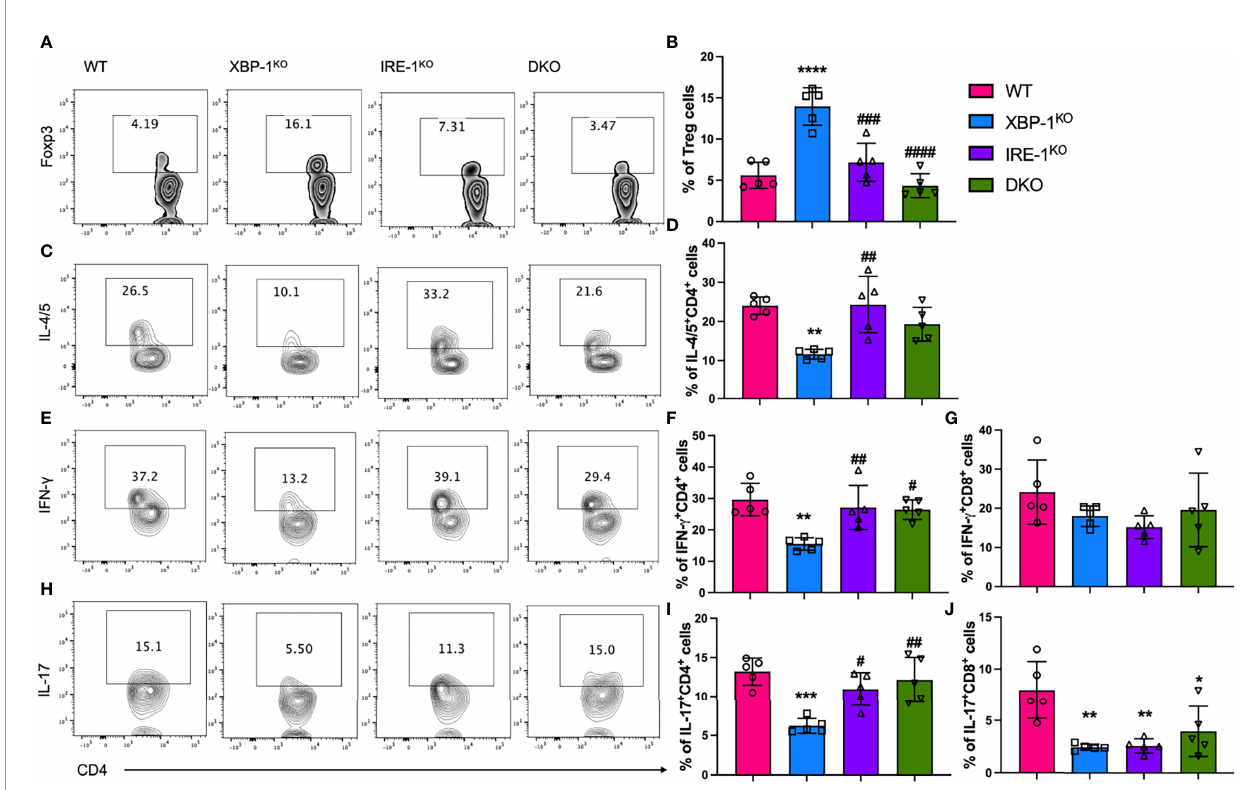
FIGURE 5 | Effect of XBP-1s and IRE-1 a on B cell ability to stimulate allogeneic T cells during cGVHD. Lethally irradiated BALB/c mice were transplanted with 5 x 10 6 TCD-BM cells from WT, XBP-1 KO , IRE-1 a KO , and DKO mice on a B6 background with 0.35 - 0.5 x 10 6 splenocytes (n=20). Recipient mice were euthanized on day 28 after BMT and single cells were isolated from recipient spleens. The expression of Foxp3 transcription factor (A, B) was measured by fl ow cytometry analysis. The cytokine levels in CD4 and CD8 T cells including IL-4/IL-5 (C, D) , IFN- g (E – G) , and IL-17 (H – J) were determined after intracellular staining by fl ow cytometry analysis. Data show the representative result from three independently repeated experiments. 20 recipient mice were used for each experiment. Statistics were performed using two-way ANOVA with Tukey ’ s multiple comparison test. *p < 0.05, **p < 0.005, ***p < 0.0005, and ****p < 0.0001 when compared to WT. # p < 0.05, ## p < 0.005, ### p < 0.0005, and #### p < 0.0001 when compared to XBP-1 KO